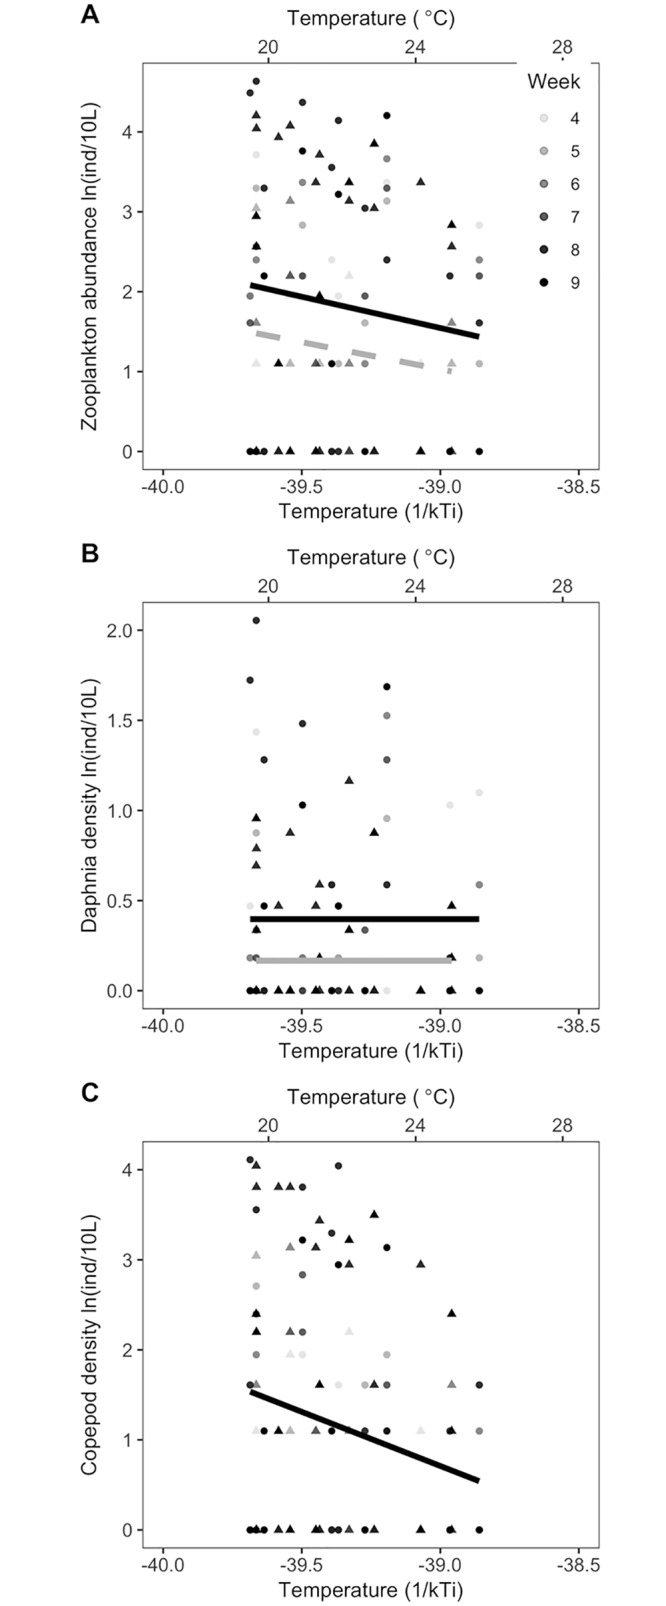
(A) Total zooplankton density (ln(ind)/10 L), comprising Daphnia and copepod taxa, declined with increasing temperature but not with predator presence. (B) Daphnia density (ind/L) declined with predators (gray dashed line, versus black line indicating trend with no predators) (Table 4), and (C) copepod spp. density (ln(ind)/10 L) declined with temperature but not predators (Table 5). Lines are regressions, with ecosystem as a random effect for ecosystems with predators (gray lines) and without predators (black solid line). Each data point is an observed total zooplankton density for crustacean taxa (Daphnia and copepods) in each ecosystem on a sampling date. Data for these figures may be found at https://doi.org/10.5281/zenodo.2652579 in GarzkeAllwks.csv. ind, individuals.